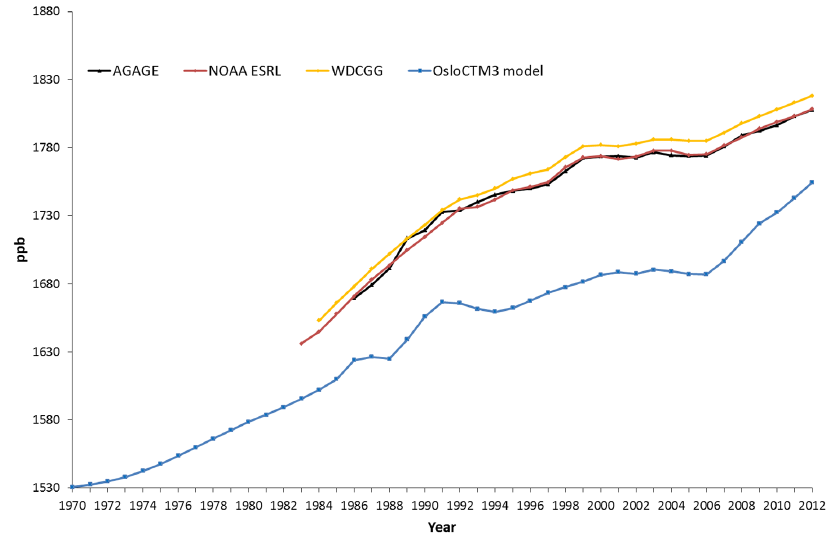
Figure 4. Global mean surface CH 4 mixing ratio in the main model simulation compared to global mean surface CH 4 mixing ratio calculated from the global networks AGAGE (http://agage.eas.gatech.edu/data_archive/global_mean/global_mean_md.txt), NOAA ESRL (http://www. esrl.noaa.gov/gmd/ccgg/mbl/data.php), and WDCGG